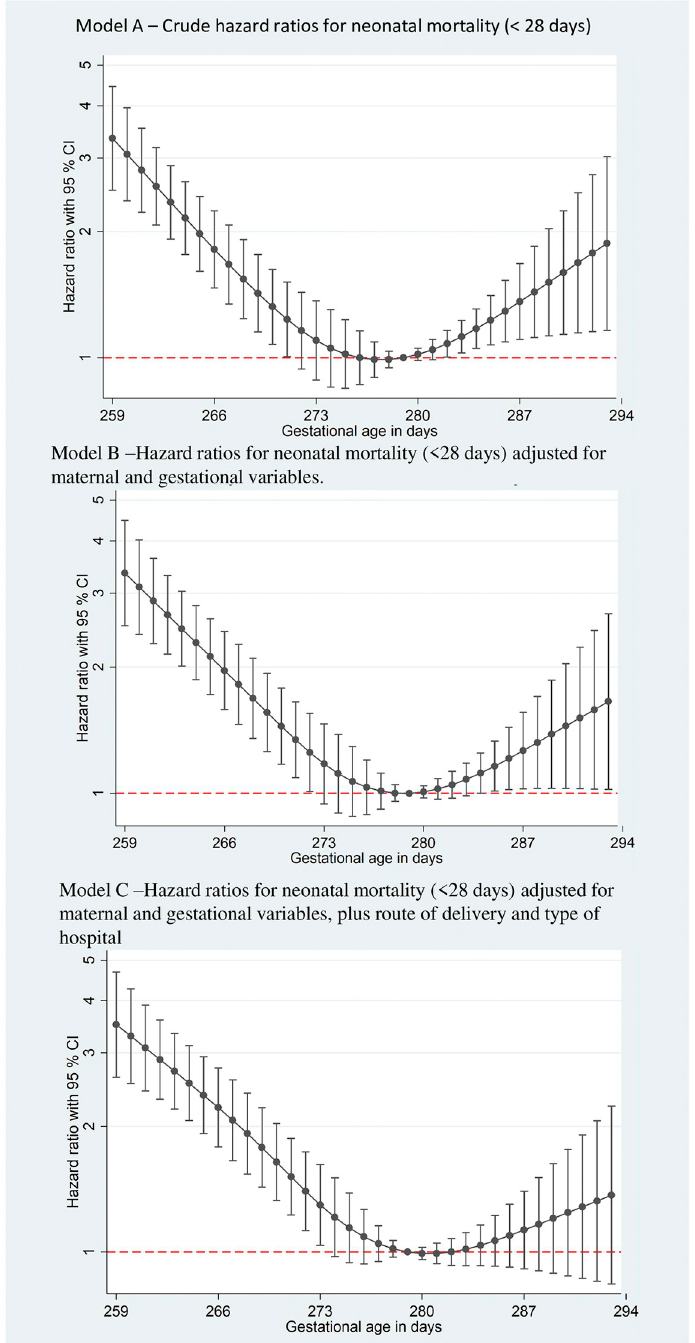
Fig 2. Hazard ratios (HRs) for neonatal mortality ( < 28 days of life). (A) Crude hazard ratios. (B) Hazard ratios adjusted for maternal variables (age, skin color, education, living with a partner, parity) and number of antenatal care visits. (C) Hazard ratios adjusted for maternal variables, number of antenatal visits, type of birth and type of hospital.